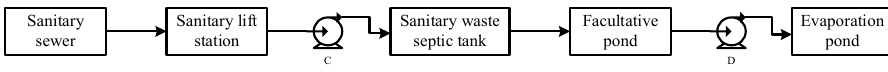
Fig. 2. Process flow of oily water drainage